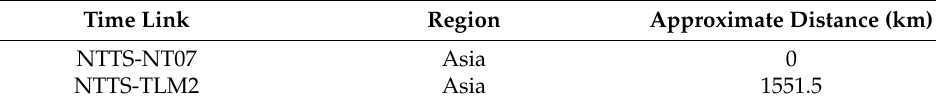
Table 4. Time links.